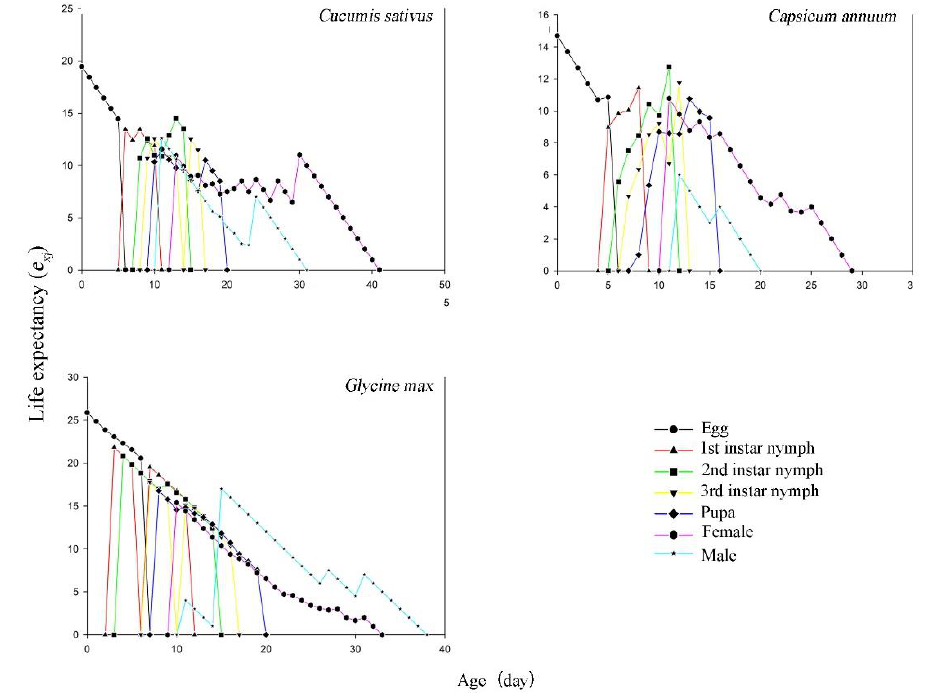
Figure 4. Life expectancy ( e xj ) of each age-stage group of Thrips flavus on different plants.